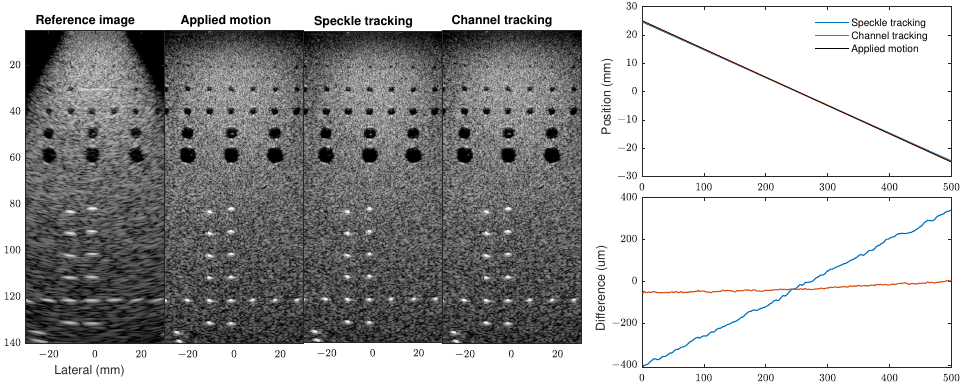
Figure 8. Phantom experiment with lateral motion applied in the translation stage. ( Left ) SSA images show significant resolution improvements compared to the reference image, produced by a 19.2 mm array (50 dB dynamic range). ( Right ) Estimated motion over 50 mm translation shows strong agreement between speckle and channel tracking estimates compared to the applied motion with the error under 400 µ m.